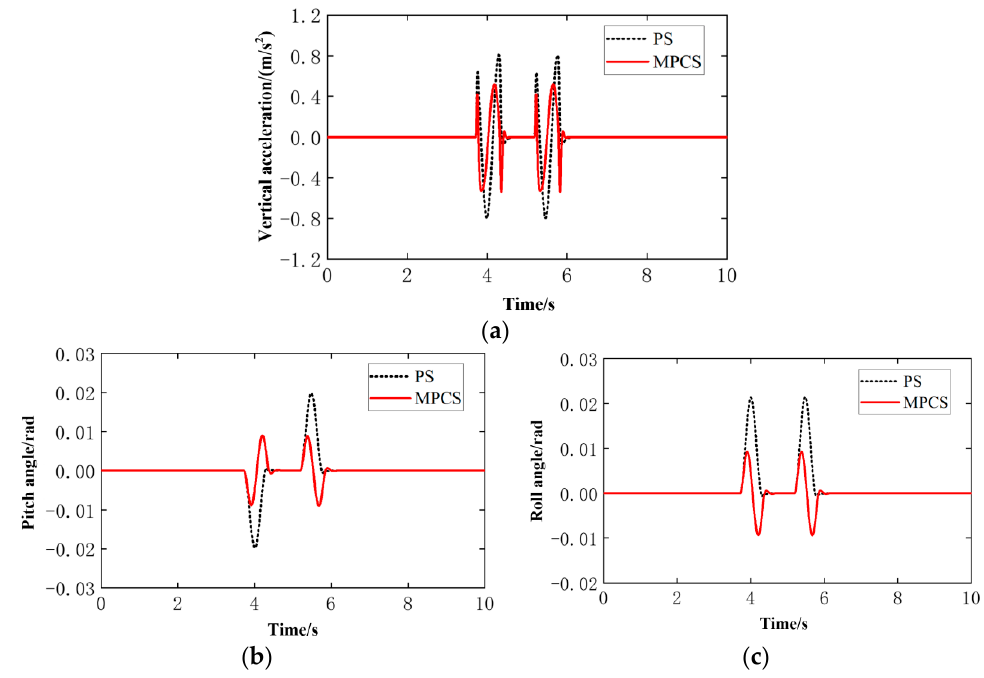
Figure 8. Simulation results of MPC attitude control for bump roads: ( a ) Heaving acceleration of car body; ( b ) Pitching angle of car body; ( c ) Rolling angle of car body.